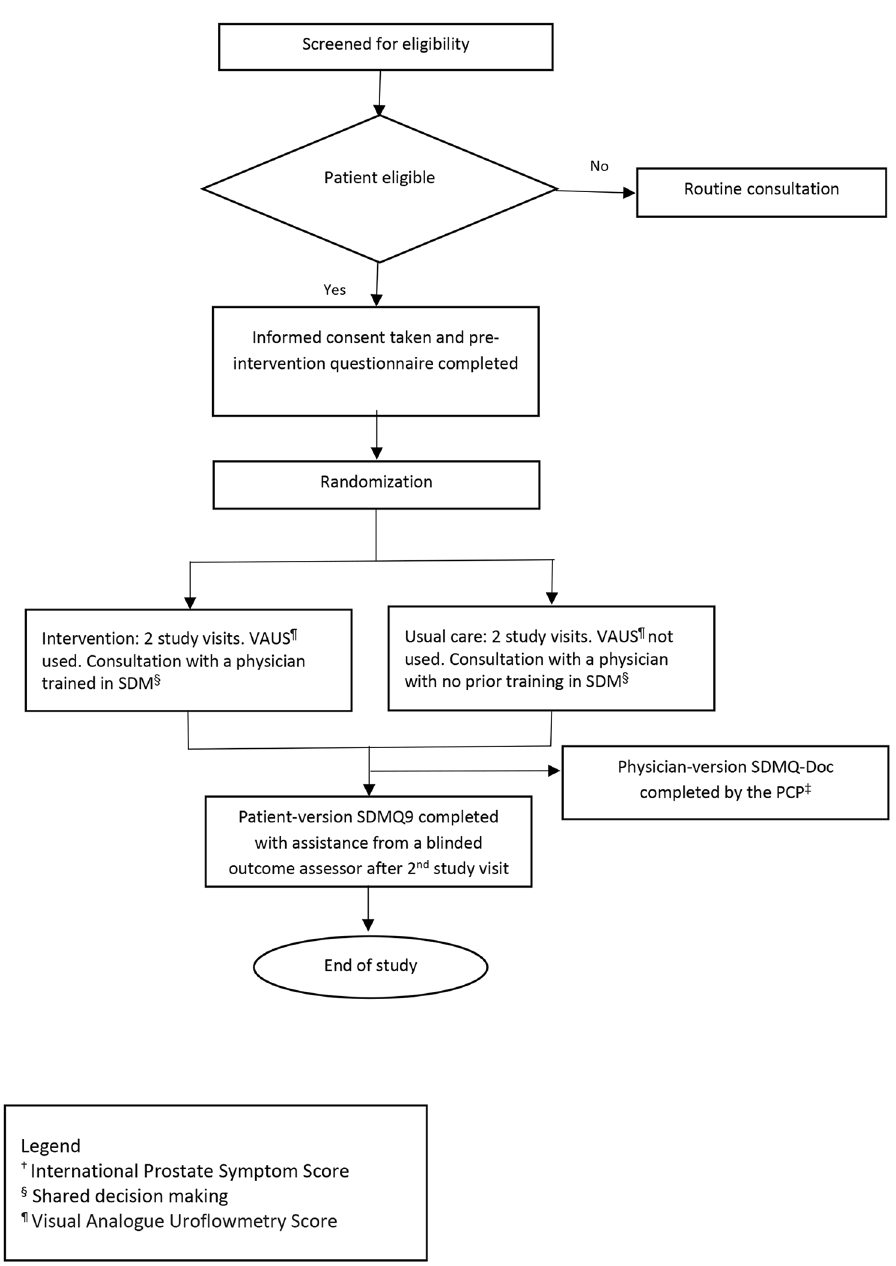
Fig. 2 Flowchart of the study